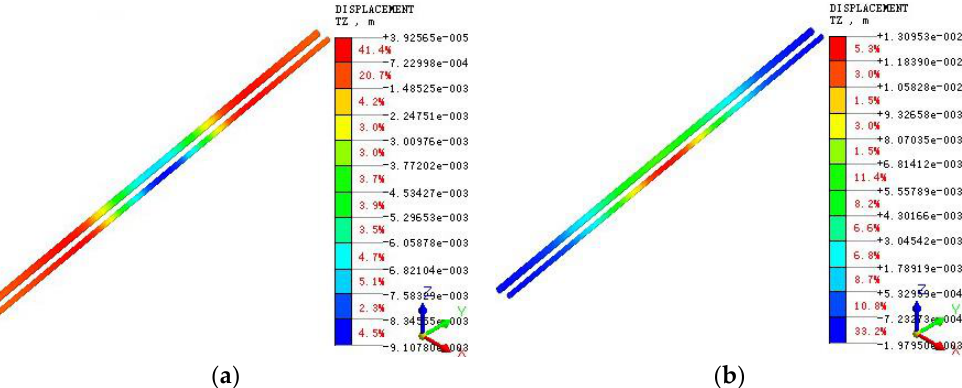
Figure 13. Contours of vertical displacements of pipelines at Excavation Step 8: ( a ) without installing pipeline suspension structure; ( b ) with installing pipeline suspension structure.